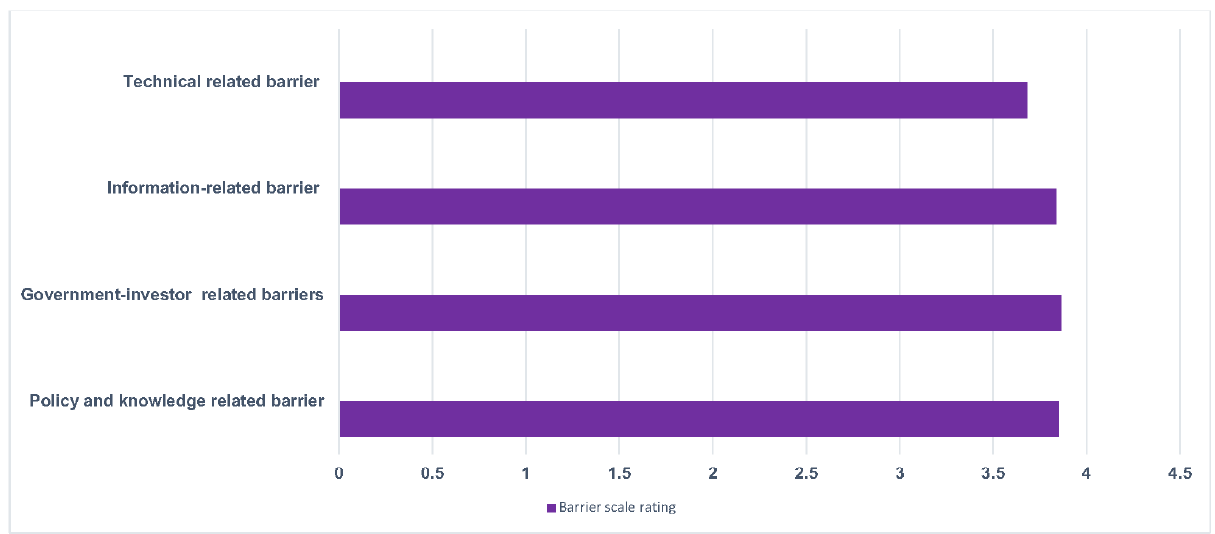
Figure 3. Ranking result of the barrier scale rating for the critical